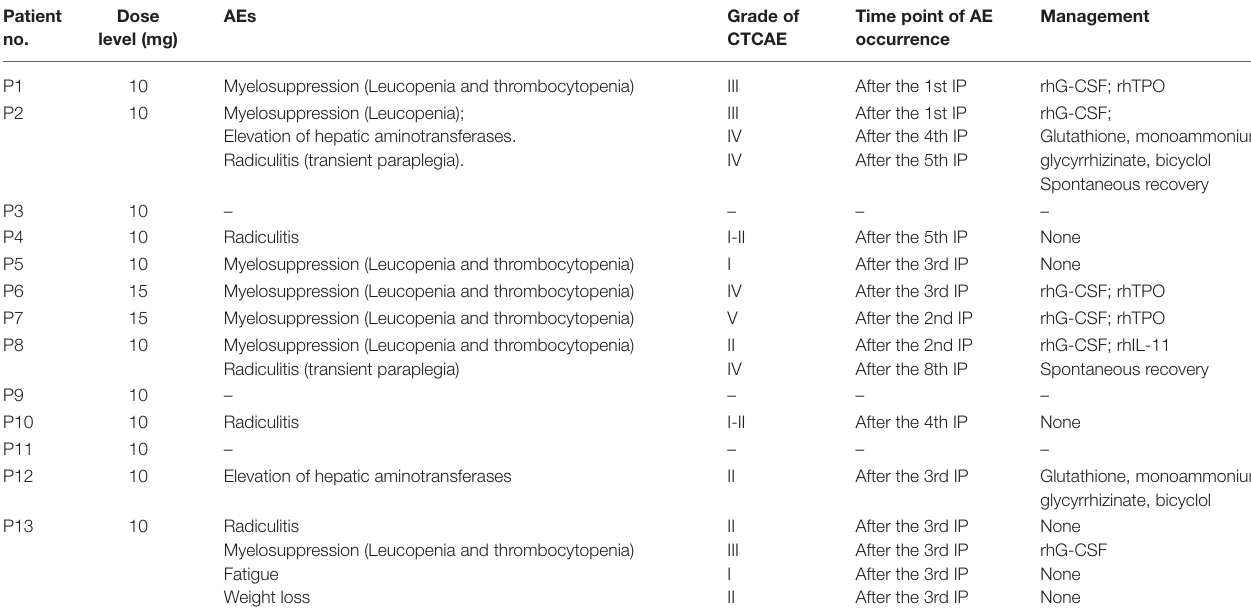
TABLE 3 | Toxicities and AEs. Patient